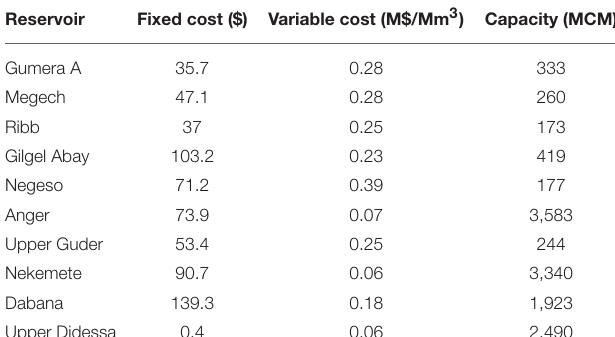
TABLE 1 | A summary of the proposed irrigation reservoirs, their proposed capacity, and their costs. Reservoir